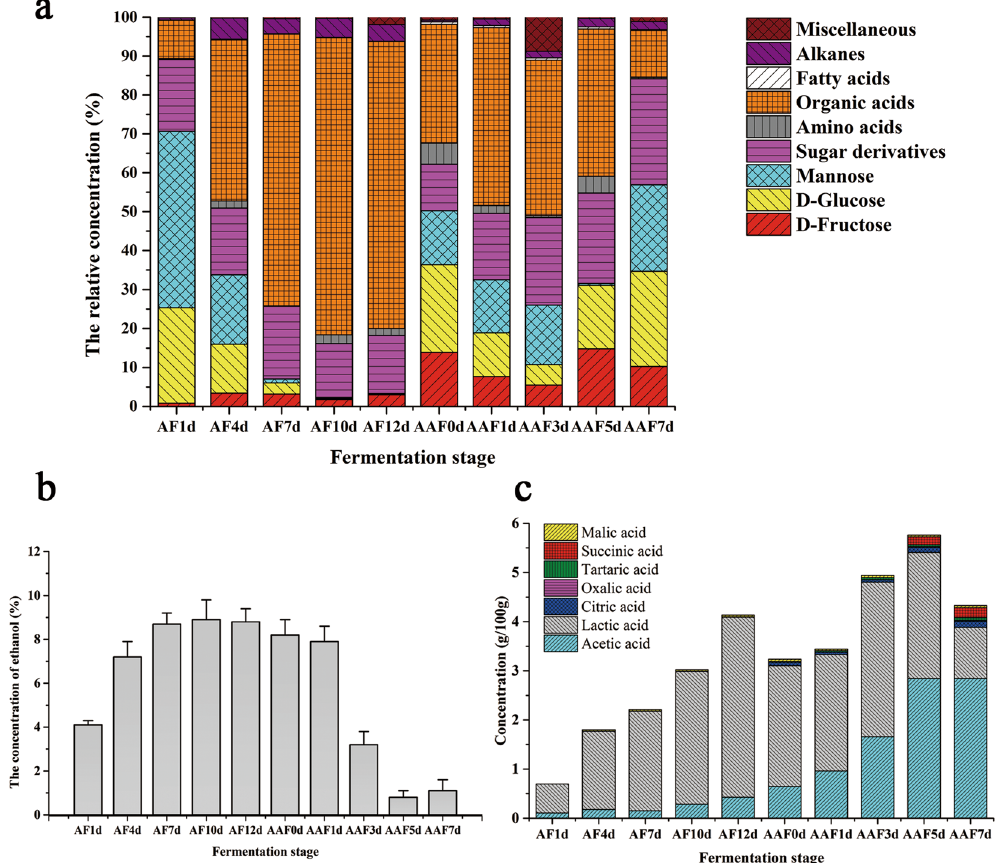
Figure 3. Distribution of metabolites in the whole fermentation of SAV. ( a ) Distribution of nonvolatile metabolites analyzed by GC–MS. Different colors represent different metabolites. All metabolites are divided into groups of sugar derivatives, alcohols, amino acids, and others, except for the relative higher abundances of glucose, fructose, and mannose. ( b ) Distribution of ethanol (%, v/v) analyzed by HPLC in different fermentation stages. ( c ) Distribution of seven dominant organic acids analyzed by HPLC in different fermentation stages. AF1d–AF12d represent specimens from 1 day to 12 days of alcohol fermentation, and AAF0d–AAF7d represent specimens from 0 day to 7 days of acetic acid